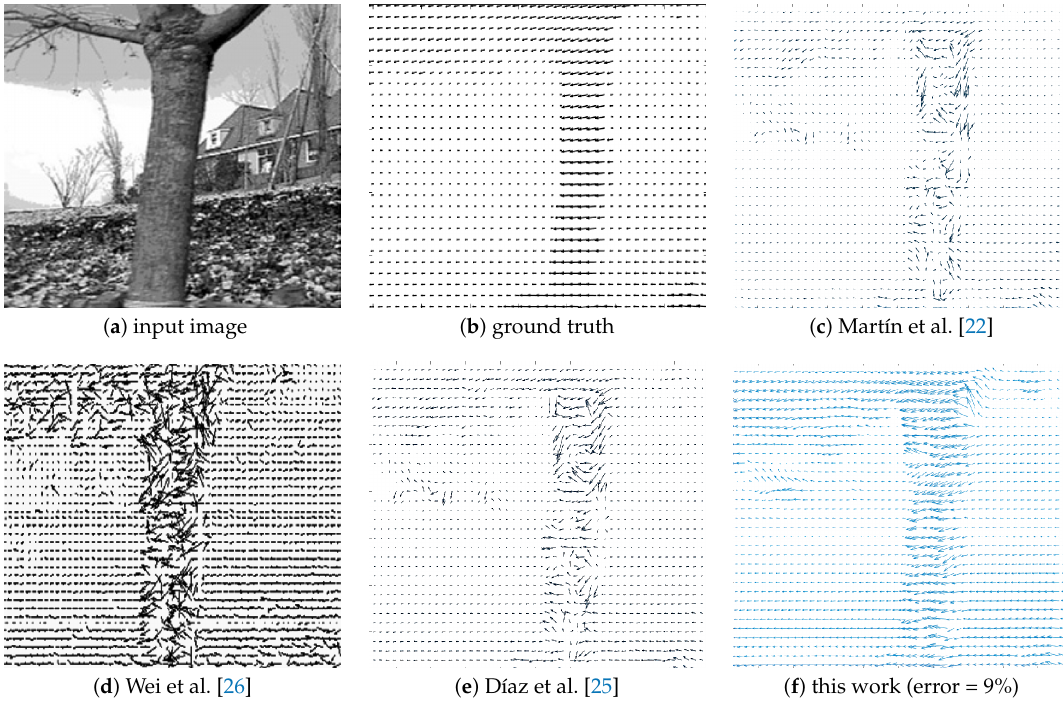
Figure 14. Accuracy performance for different FPGA-based optical flow algorithms.